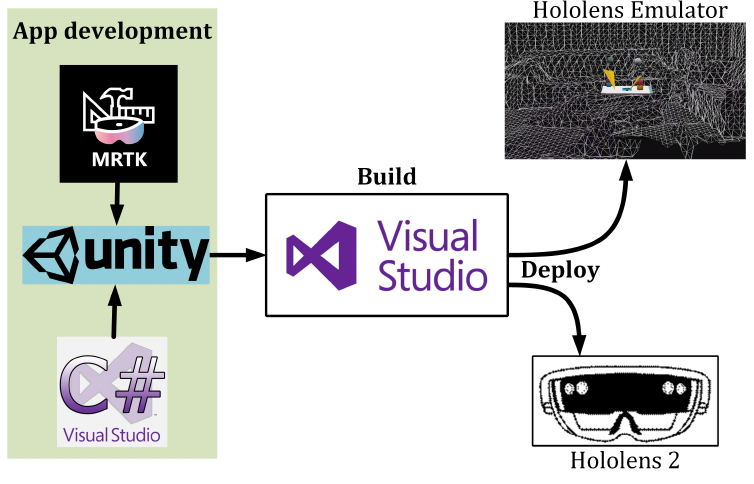
Figure 1. Schematic diagram of how the proposed system